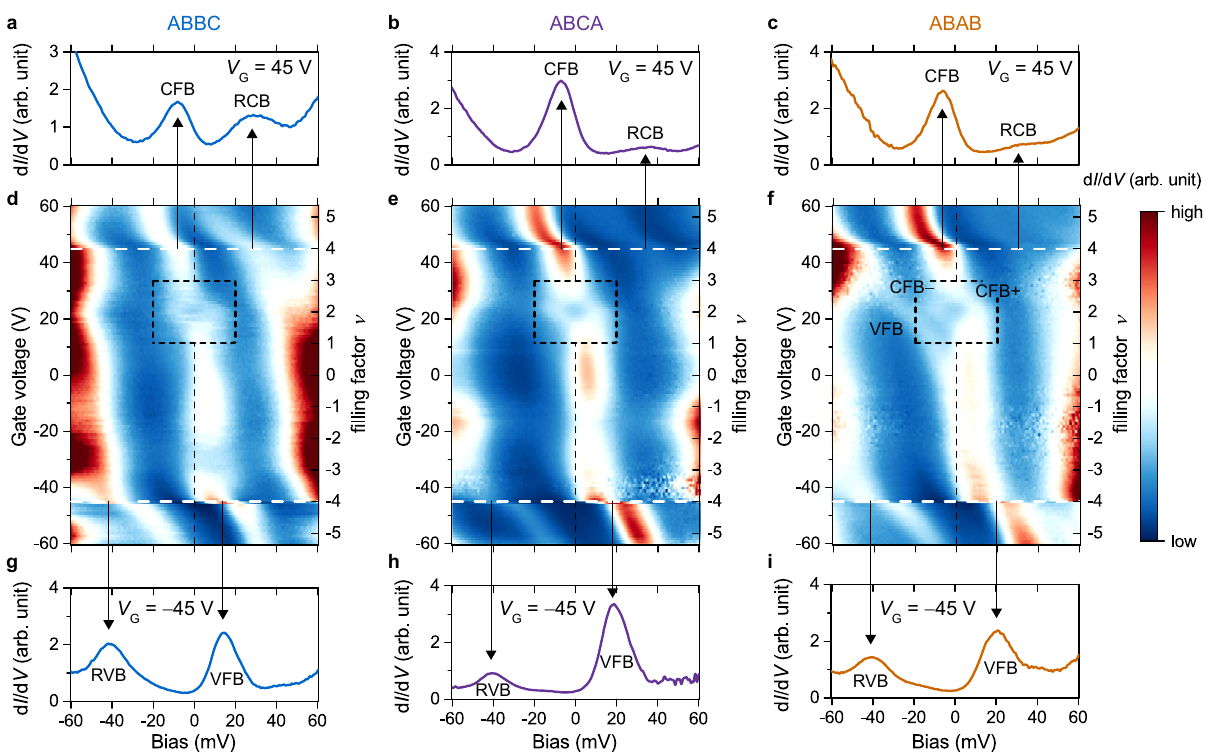
Fig. 4 Gate-dependent d I /d V spectroscopy for three different stacking regions. a – c d I /d V spectra for three stacking regions for V G = 45 V ( ν = 4). d – f Gate-dependent d I /d V density plot for three stacking regions over gate-voltage range – 60 V < V G < 60 V. The vertical black dashed line denotes zero bias (the Fermi level). The black dashed box highlights correlation-driven splitting of the CFB peak near ν ≈ 2. g – i d I /d V spectra for three stacking regions for V G = – 45 V ( ν = – 4). Spectroscopy parameters: modulation voltage V RMS = 1 mV; initial V Bias = – 100 mV, I 0 = 0.5 nA. CFB conduction fl at band, VFB valence fl at band, RCB remote conduction band, RVB remote valence